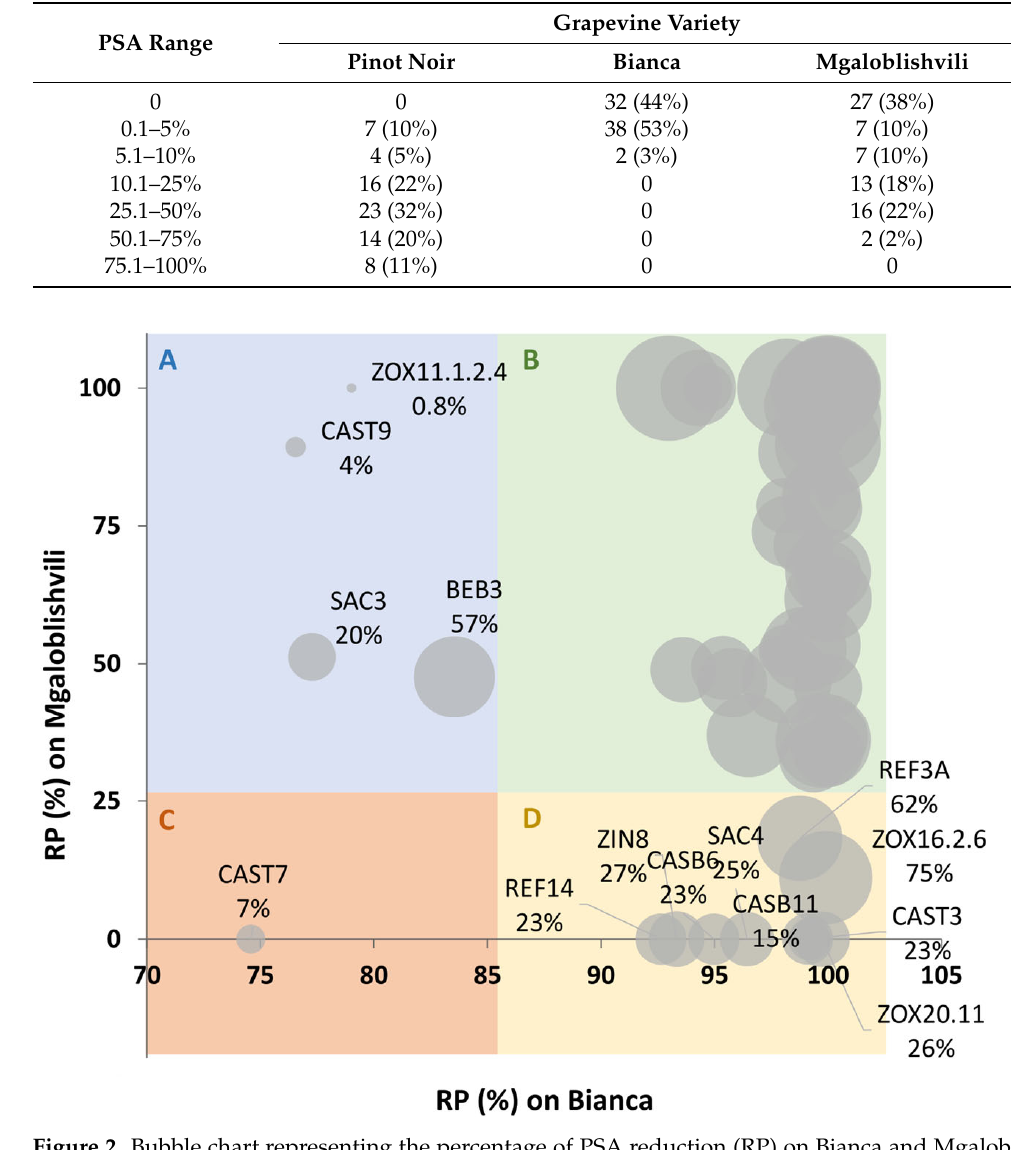
Table 3. Number and percentage (in brackets) of strains grouped in different PSA ranges on Pinot noir, Bianca and Mgaloblishvili.